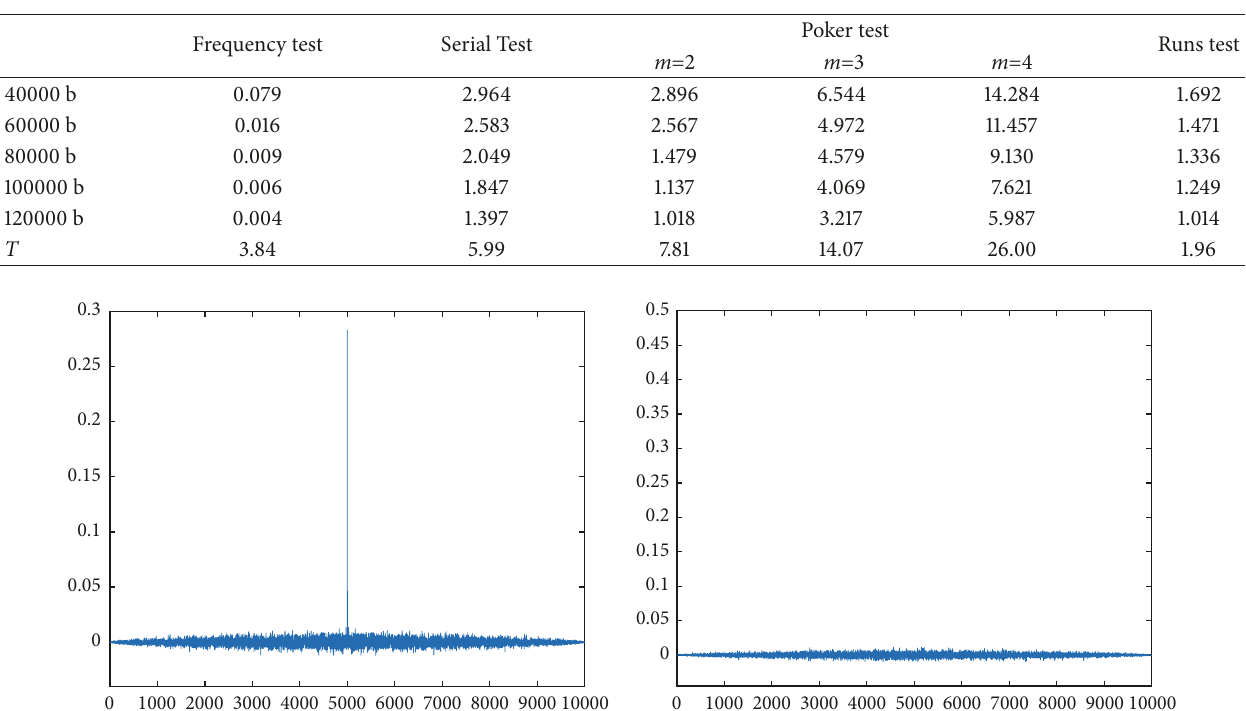
Table 1: Results of Beker and Piper’s statistical test.